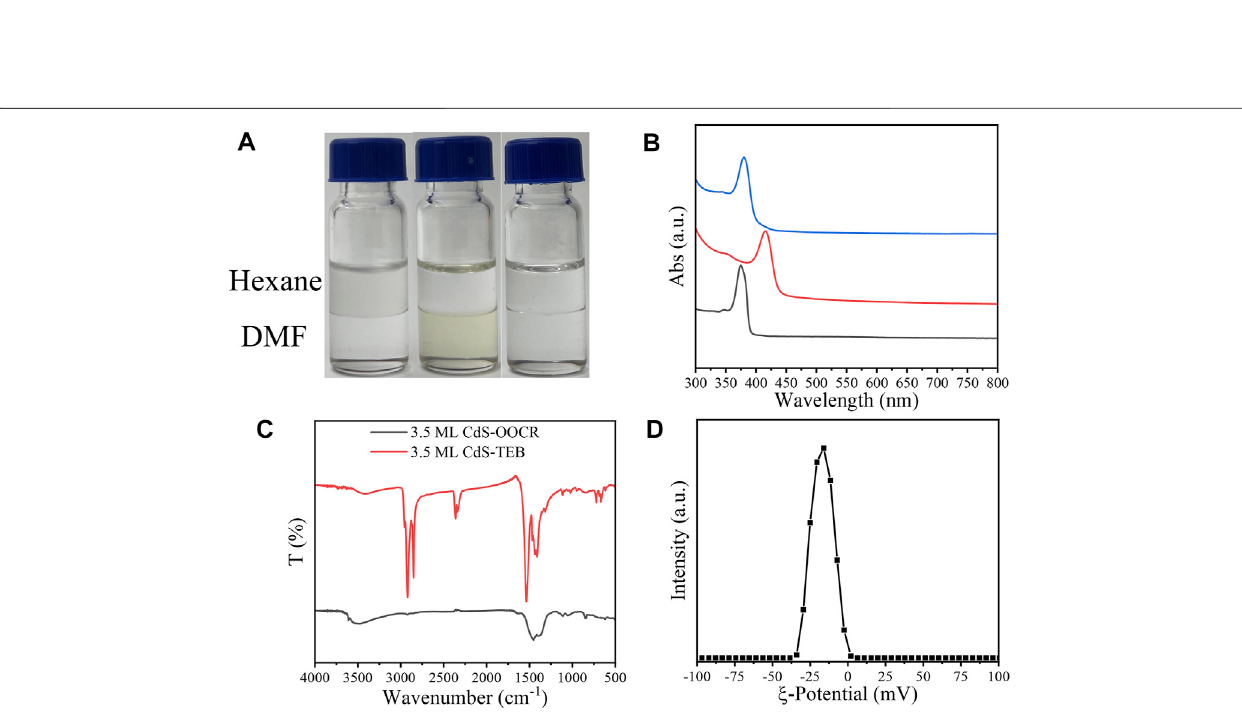
FIGURE5| (A) UV-visabsorptionand PL spectraofCdSe nanoplatelets capped withRCOO − orTEB,respectively. (B) The PL decay curves ofNPLs capped with RCOO − and TEB. (C,D) The corresponding images of NPLs irradiated with white light and UV light (365 nm), respectively. (C,D) The CdSe NPLs capped with RCOO- (left) and TEB- (right) irradiated with white light and UV light (365 nm), respectively.